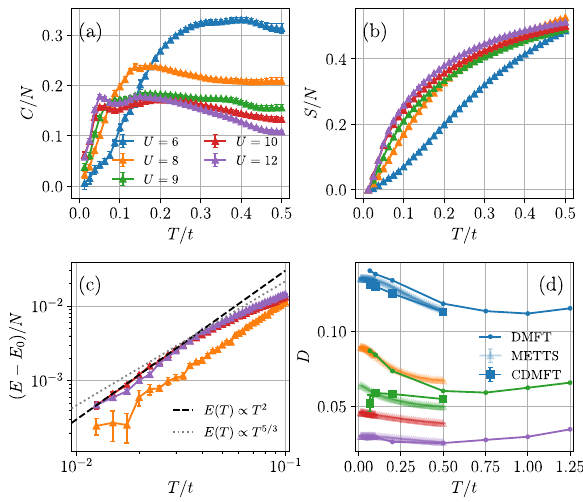
FIG. 5. Thermodynamics of the 16 × 4 YC4 cylinder from METTS for different values of U=t . We employed a maximal 3000 . (a) Specific heat C . At U=t ¼ 9 , bond dimension D max ¼ 10, 12 we observe a broad continuum at higher temperatures with a small peak at T=t ≈ 0 . 05 . (b) Thermal entropy S . We observe an increase in entropy when increasing U=t at low temperature. (c) Internal energy E as a function of temperature on a refined heat. The black and gray lines indicate E ∝ T 2 and E ∝ T 5 = 3